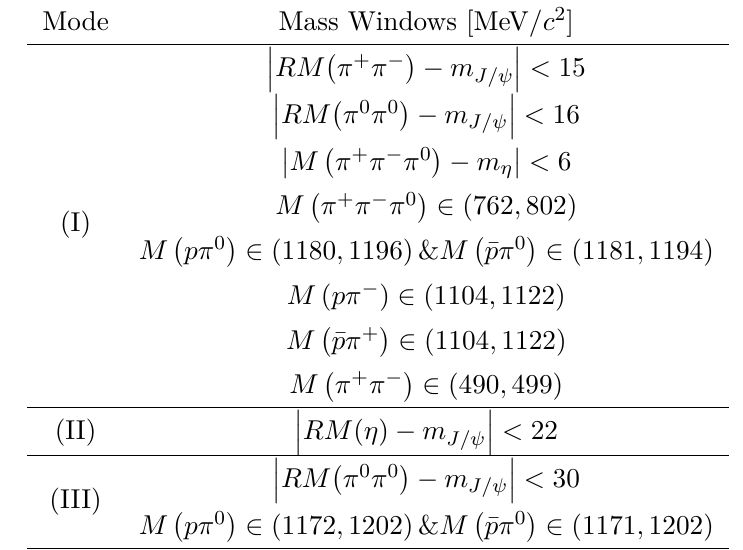
Table 1 . Mass windows used as vetoes in each exclusive